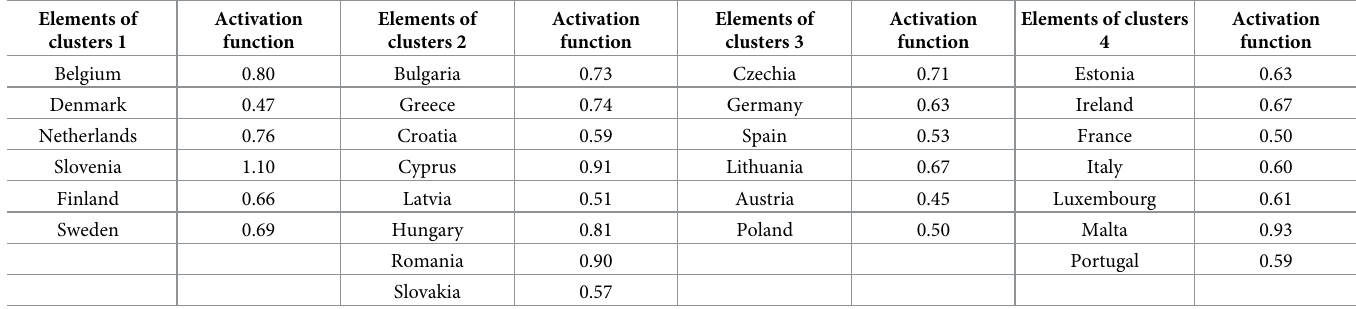
Table 10. The division of the EU countries into similar groups based on the examined indicators for large enterprises together with activation values (distance from the center of the cluster). Elements of clusters